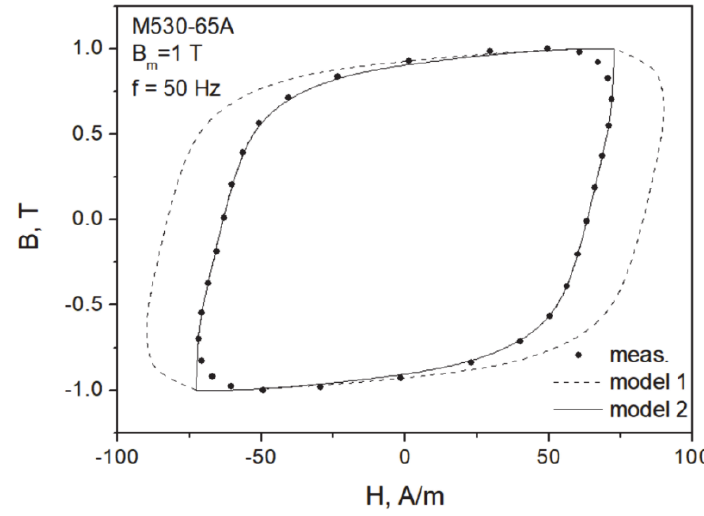
Figure 8. Measured and modeled hysteresis loop for Bm = 1.0 T, f = 50 Hz, M530 ‐ 65A grade.